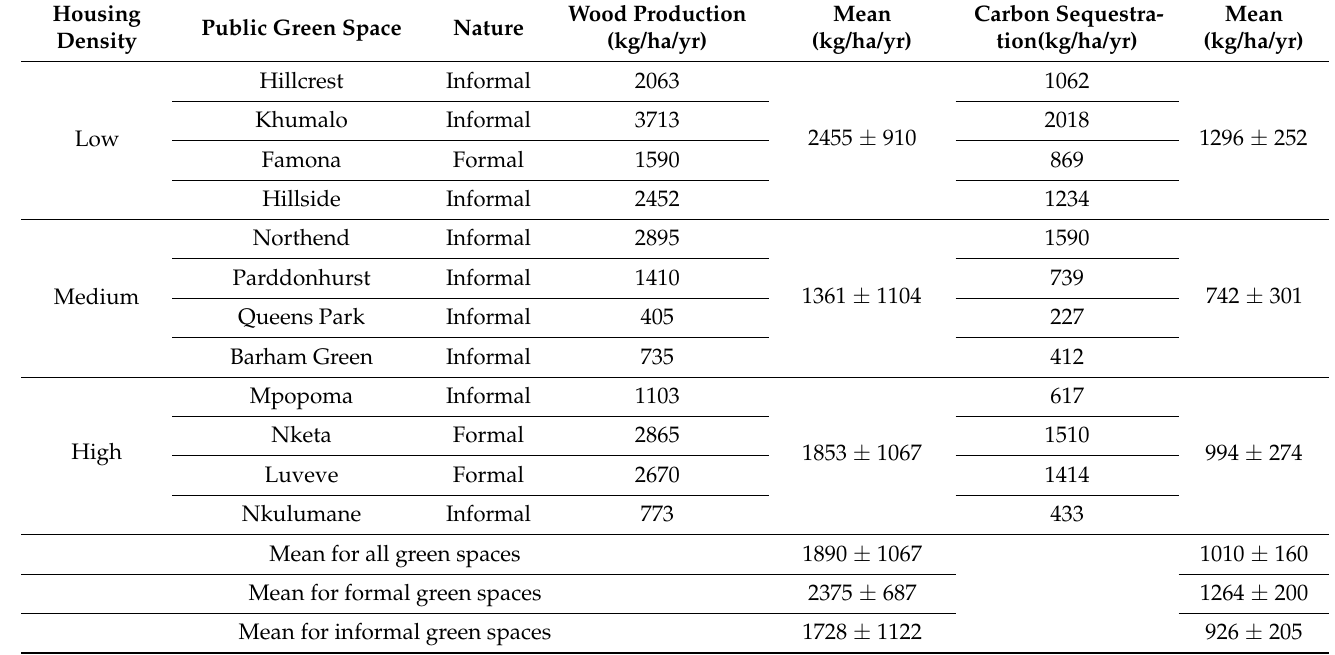
Table 2. Wood generated per green space per